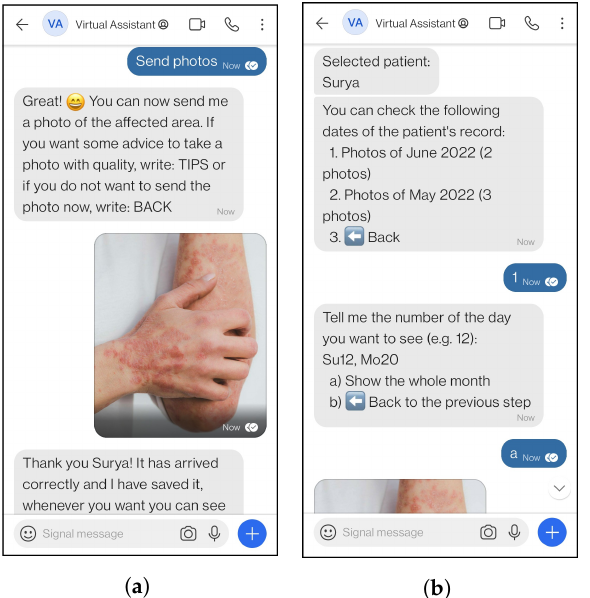
Figure 2. Example of real interactions with the virtual assistant. ( a ) Patient interaction using Send photos functionality. ( b ) Healthcare professional interaction using Record